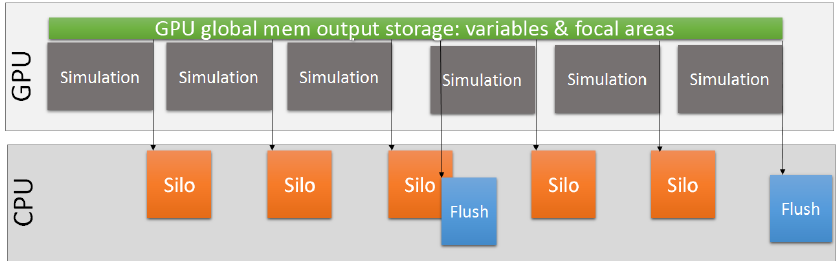
Figure 12. TRITON-G computational flow; mem: memory.